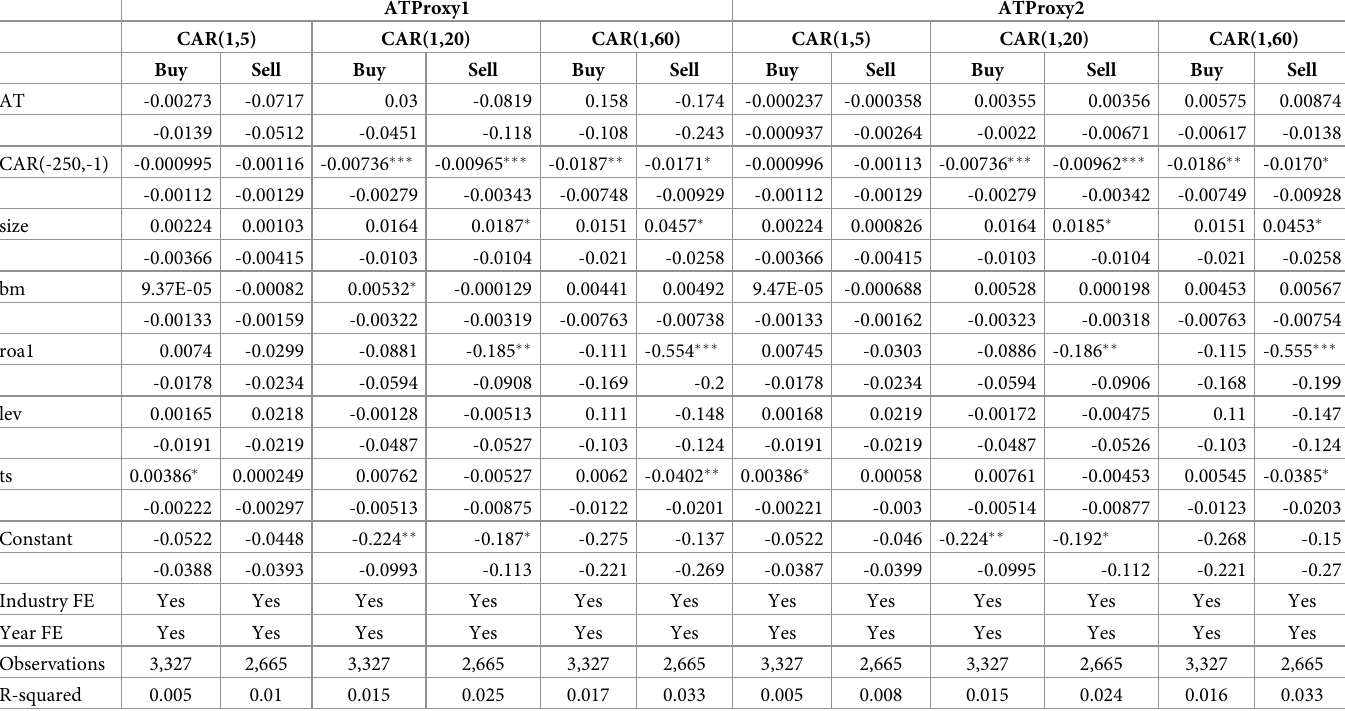
Table 2. Baseline